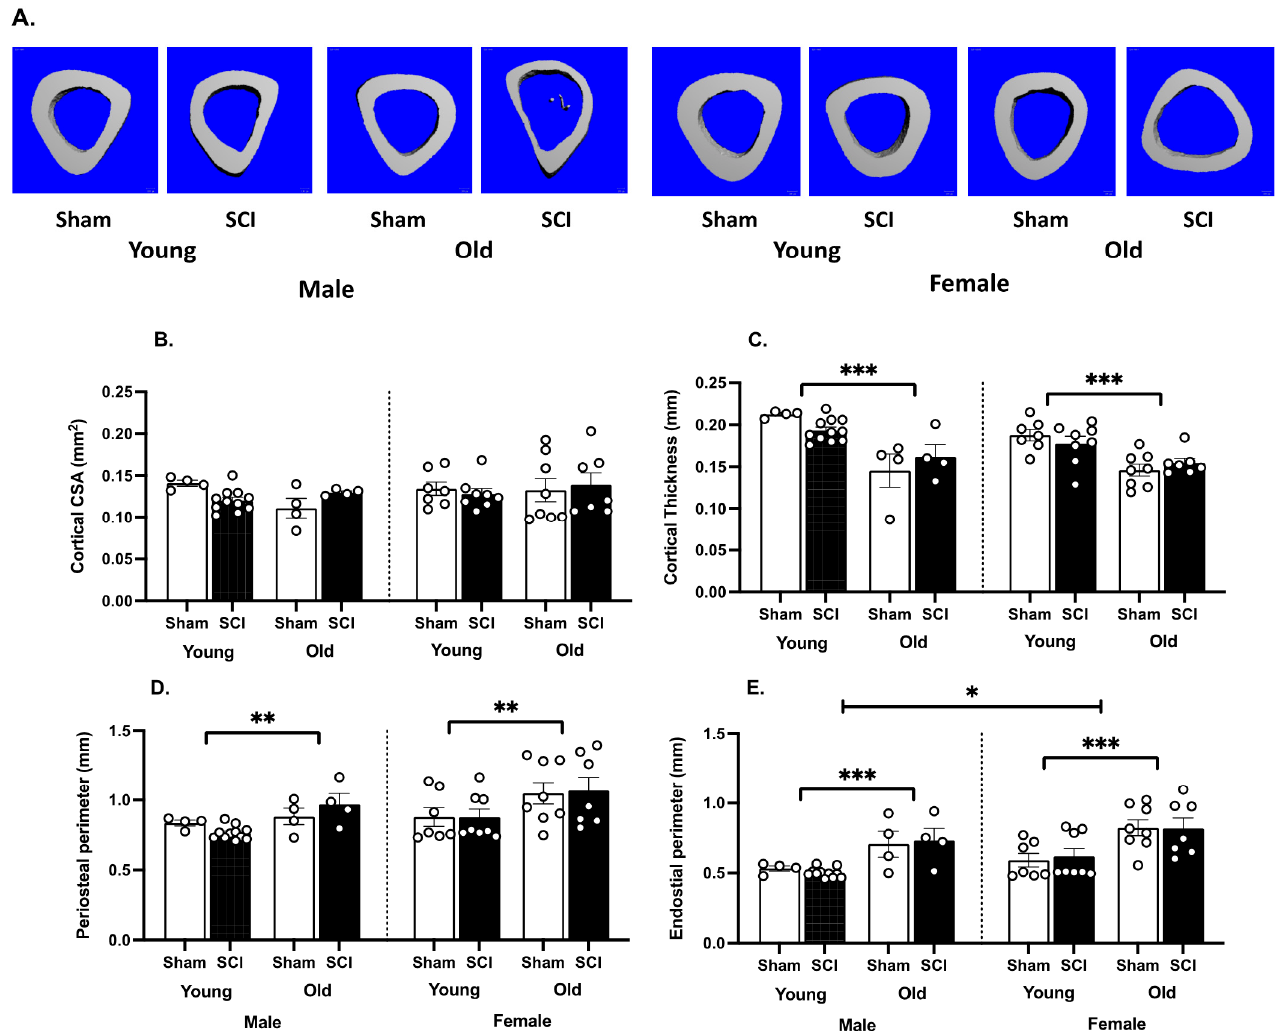
Figure 5. SCI did not affect cortical bone structure after only one month. ( A ). Coronal views of mi- croCT 3D reconstructions of the 50 contiguous slices of the tibial mid-diaphysis from a representative mouse in each group. ( B ). There was also no effect of age or sex on cortical bone cross sectional area. ( C ). Age did, however, decrease cortical thickness and ( D ). increased the periosteal perimeter. ( E ). Both age and sex also affected the endosteal perimeter. The endosteal perimeter increased with age, and was larger in females than males. Means ± SEMs are plotted for each group. Individual subjects are shown with the round, white symbols. n = 4 sham and 5 SCI old males; 4 sham and 11 SCI young males; 8 sham and 7 SCI old females; 7 sham and 8 SCI young females. *** p < 0.001, ** p < 0.01, * p < 0.05.